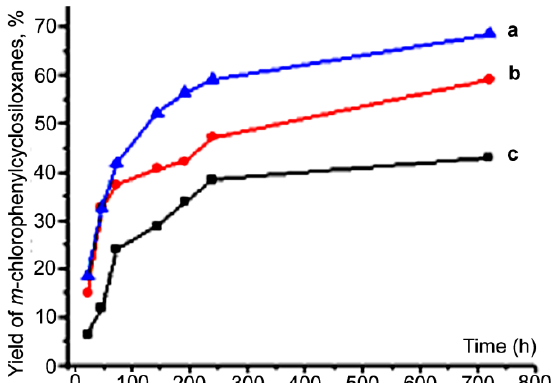
Figure 7. Dependence of the yield of m -chlorophenylcyclosiloxanes from the hydrolysis–condensation reaction of 2 on time at di ff erent concentrations C HCl in water-acetone solutions: 0.056 ( a ), 0.047 ( b ), and 0.032 mol L − 1 ( c ).